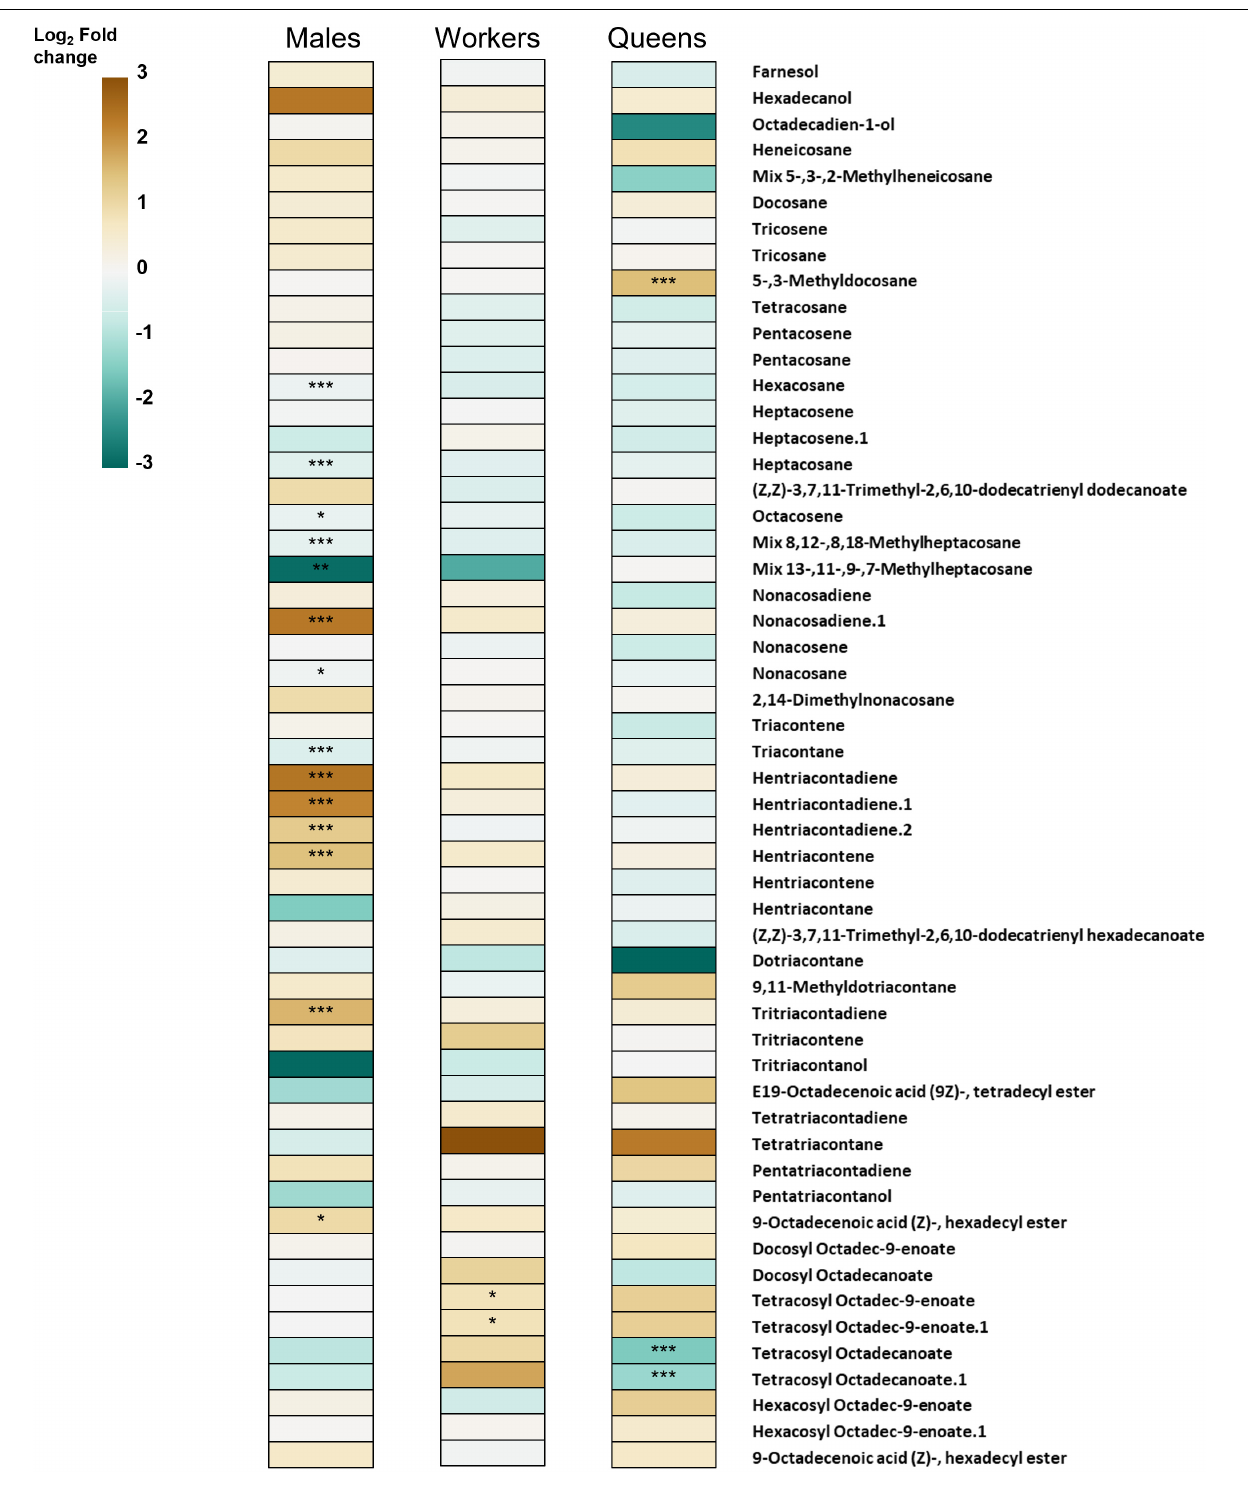
Frontiers in Ecology and Evolution |